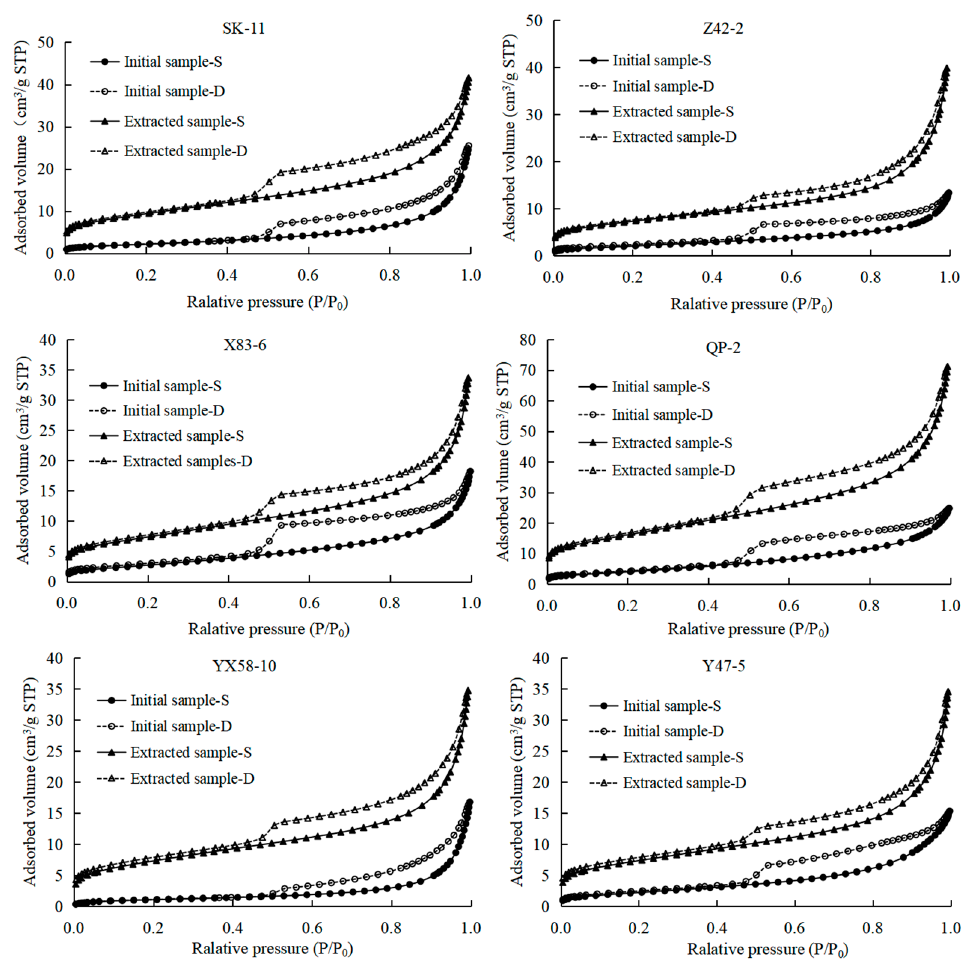
Figure 4. Low ‐ pressure N 2 sorption and desorption isotherms of the initial and extracted samples for the typical K 2 qn shales.